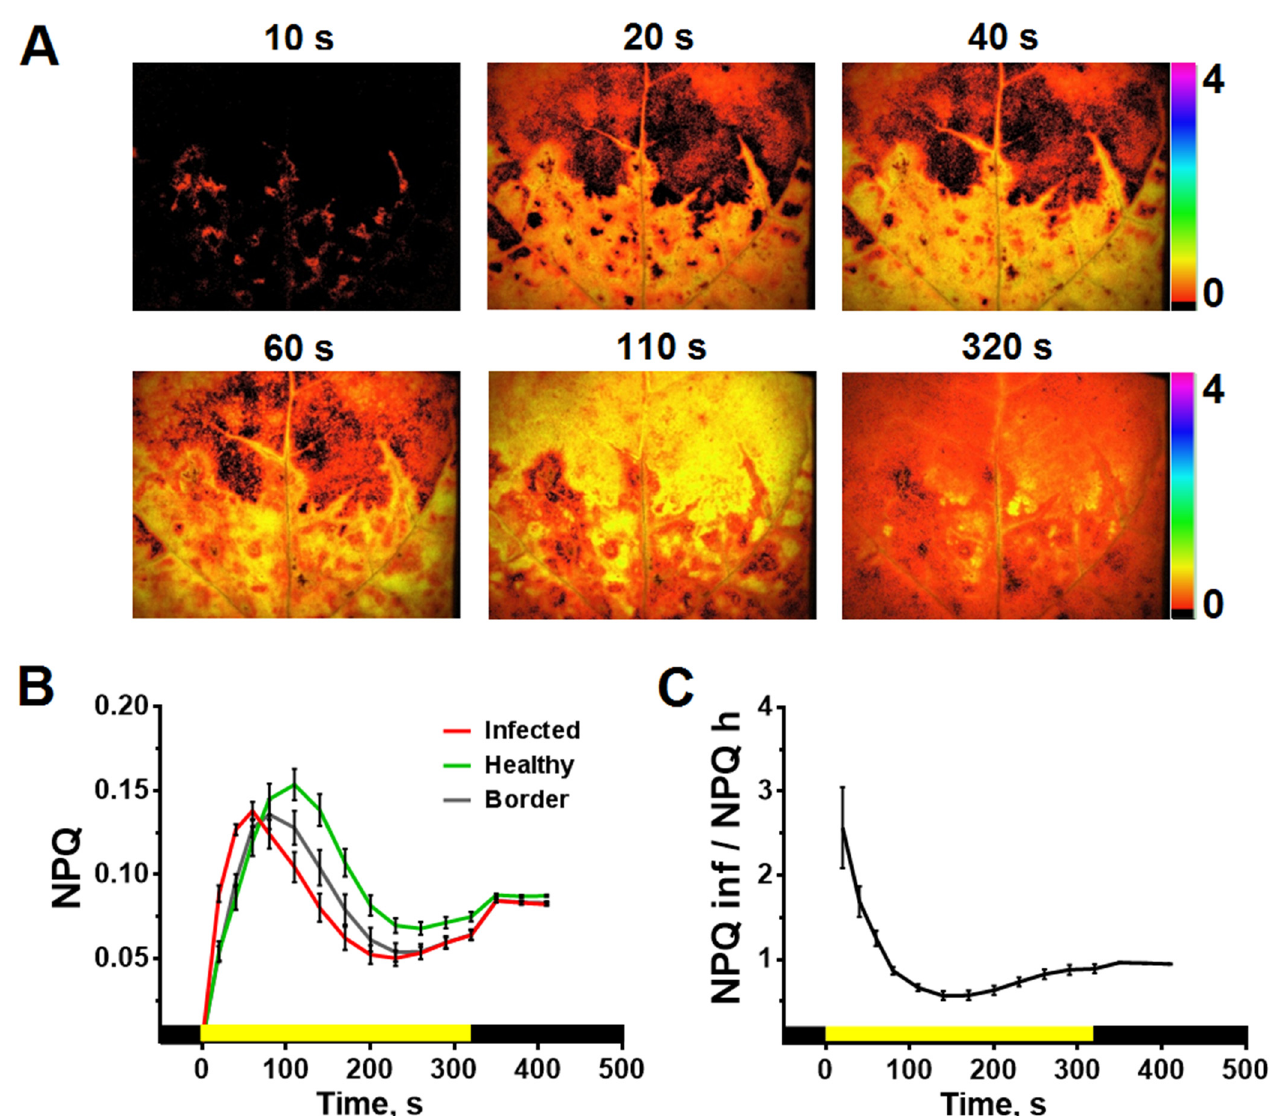
Figure 5. Influence of PVX on the time-course of non-photochemical fluorescence quenching (NPQ) ( n = 25): ( A ) NPQ images obtained from PVX-GFP infected tenth tobacco leaf at different times after actinic light (AL) was switched on. The color scale bars indicate the NPQ value given in false colors. ( B ) NPQ light-induced curves obtained from healthy, infected, and border areas of the leaf. ( C ) The ratios of the NPQ values of the infected and healthy areas of the leaf. The moment of the AL switching on is taken as zero. Values are mean ± SEM. The ratios of the NPQ values are statistically significantly differ from 1 in the range from 20 to 320 s ( t -test, p < 0.05). One-way ANOVA was performed to analyze the differences between ChlF parameters ratios (infected/healthy) at different time points of their dynamics (data are shown in Table S2).